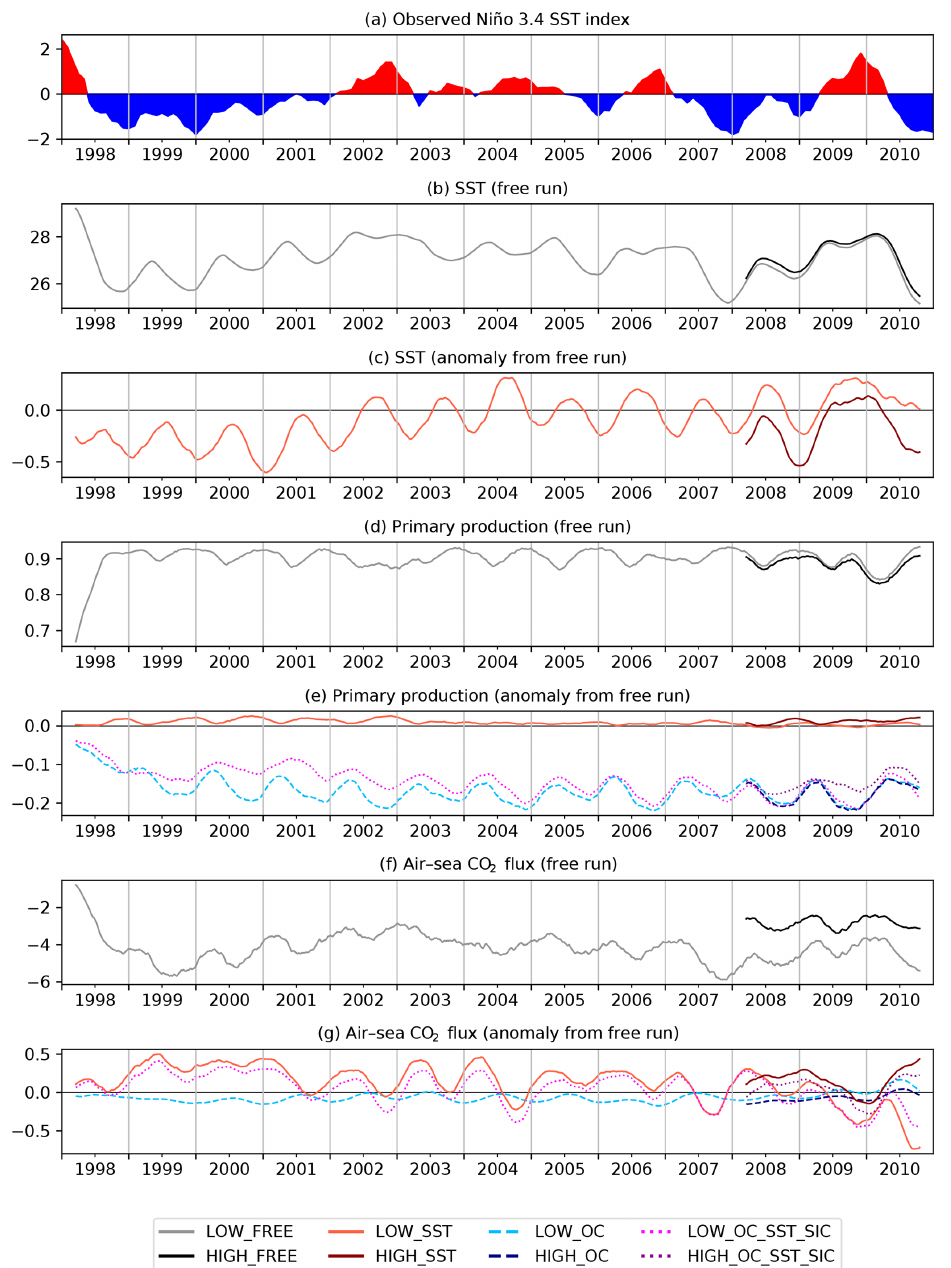
Figure 8. The 5-month running mean time series of variables averaged over the Niño 3.4 region (5 ◦ N–5 ◦ S, 170–120 ◦ W). (a) Observed Niño 3.4 SST index (Trenberth, 1997) as calculated from HadISST1 data (Rayner et al., 2003) and downloaded from https://psl.noaa.gov/ gcos_wgsp/Timeseries/Data/nino34.long.anom.data (last access: 28 May 2020). (b) SST in free runs, (c) anomaly of SST from free runs, (d) vertically integrated primary production in free runs, (e) anomaly of vertically integrated primary production from free runs, (f) air–sea CO 2 flux in free runs, (g) anomaly of air–sea CO 2 flux from free